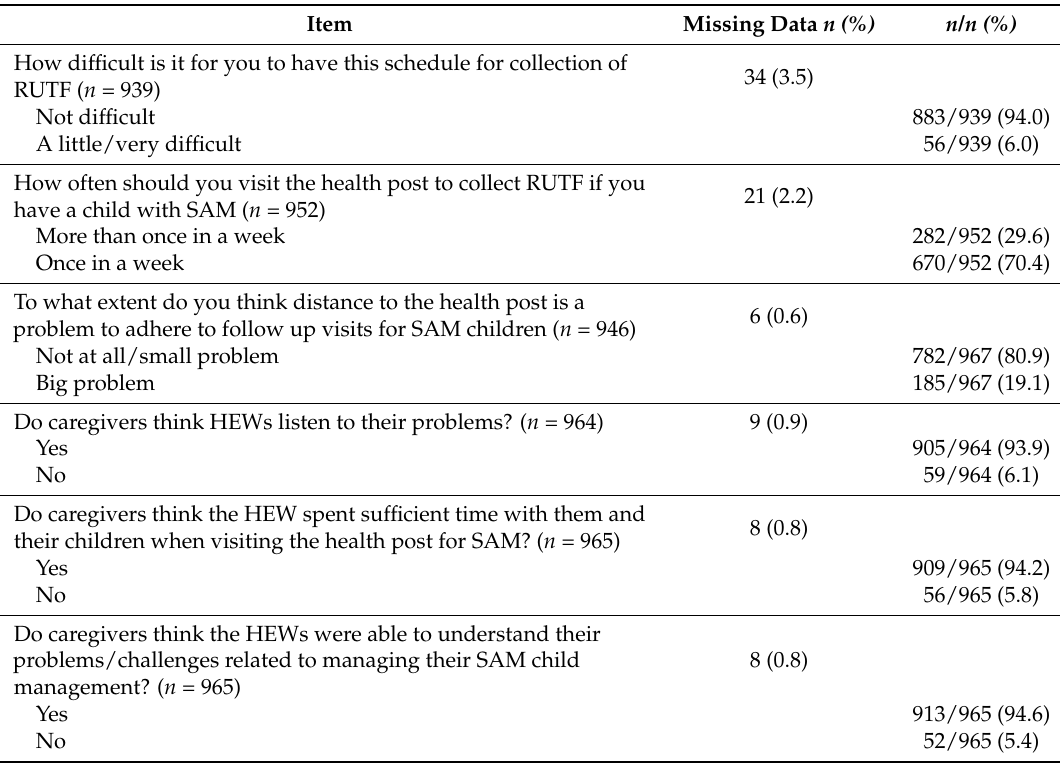
Table 3. Caregivers’ views of community-based outpatient therapeutic program service provision ( n =